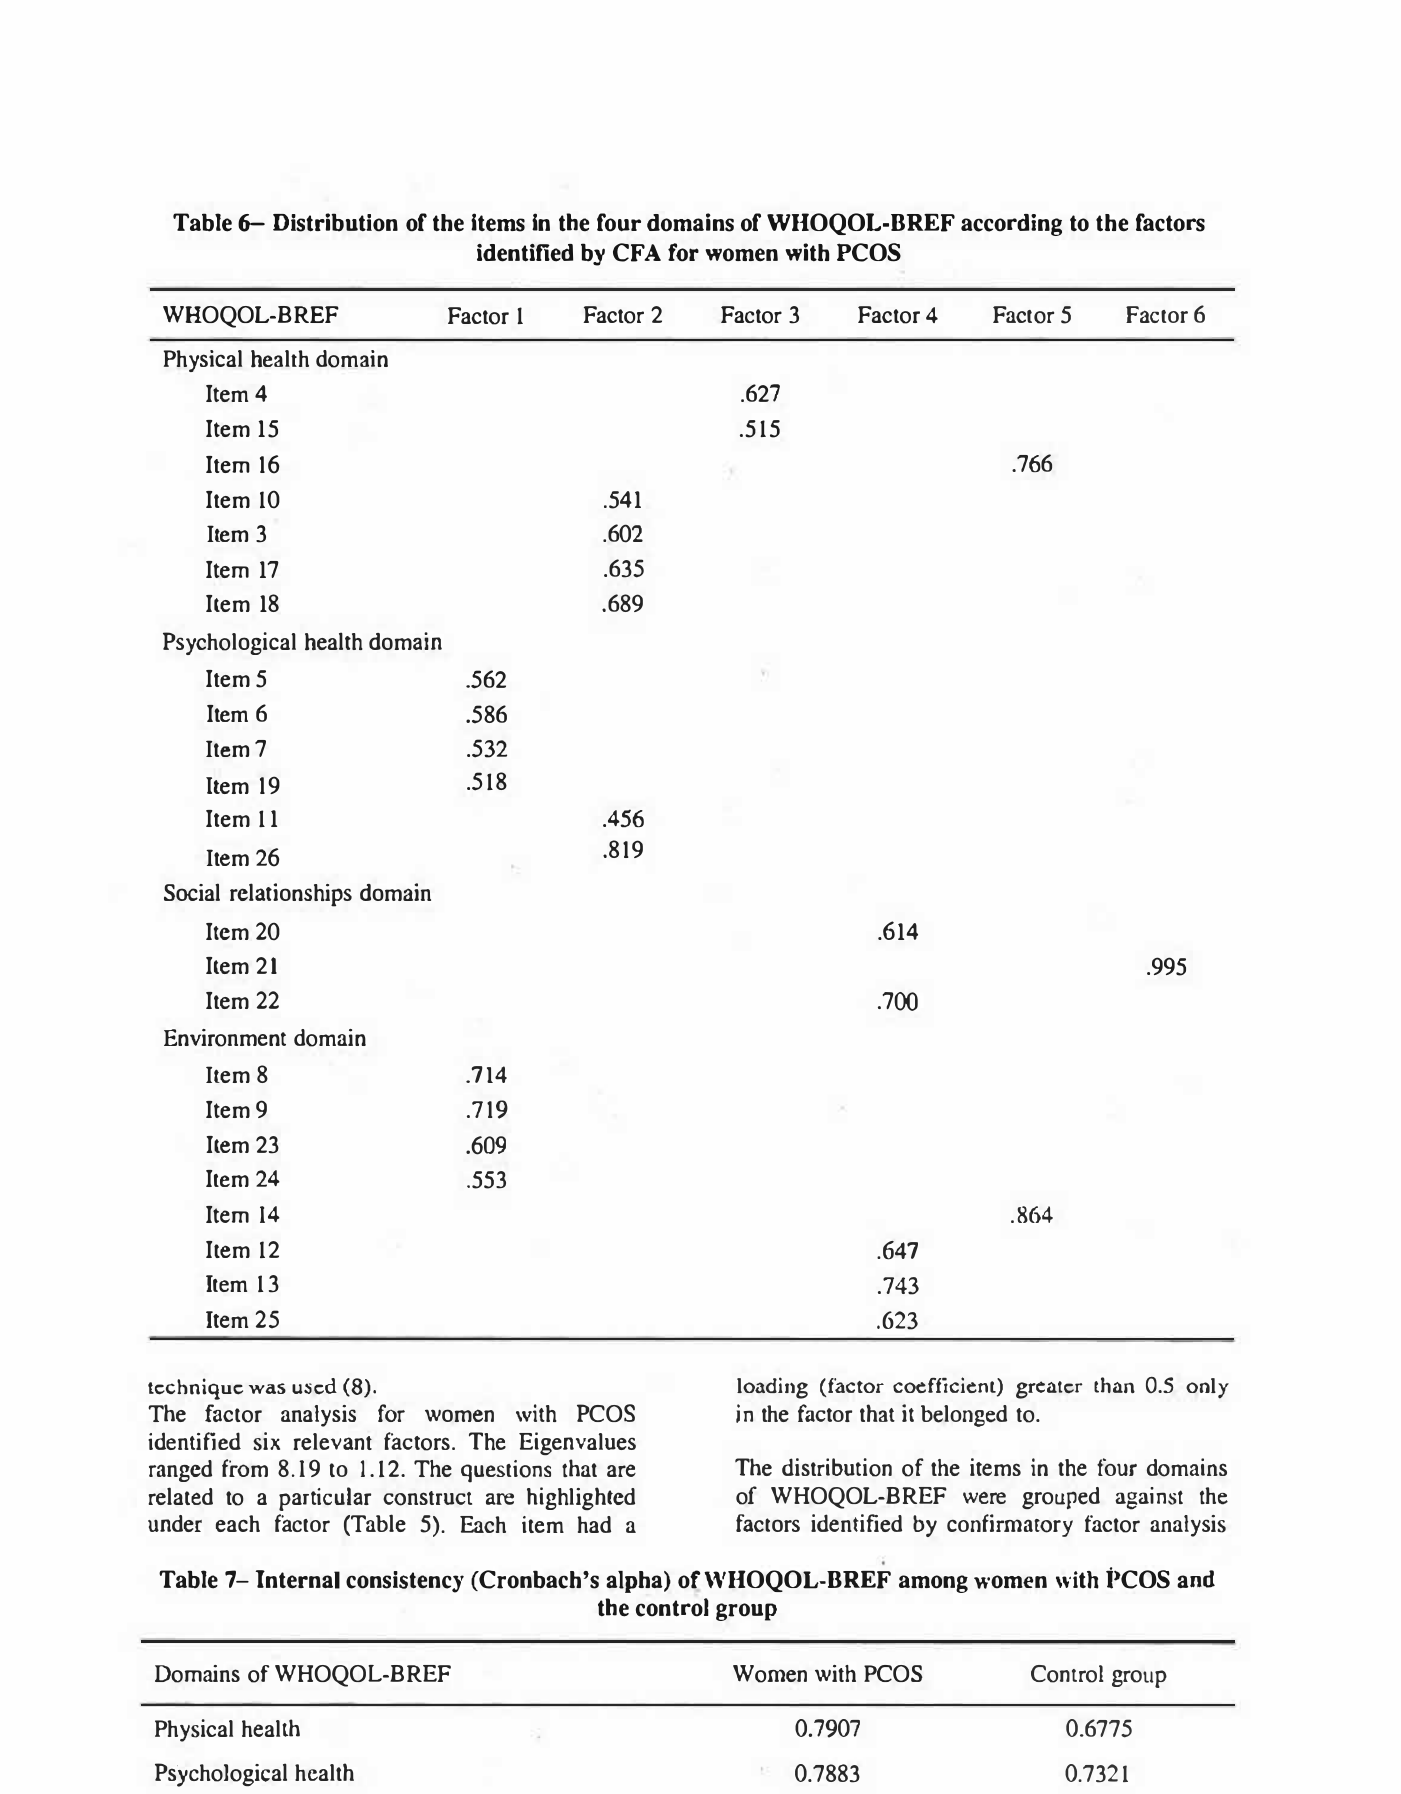
Table 6- Distribution of the Items In the four domains of WHOQOL-BREF according to the factors identified by CFA for women